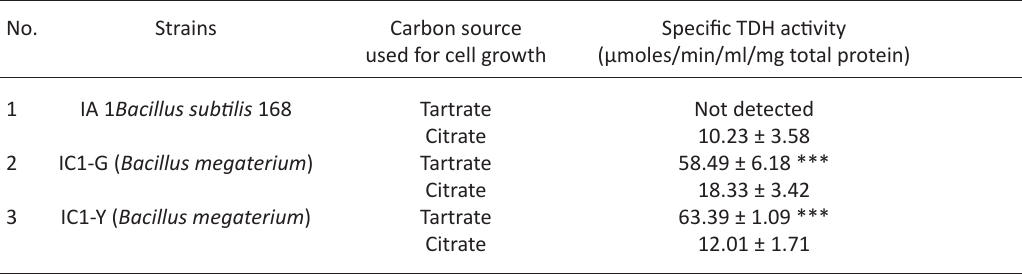
Table 2. Occurrence of inducible tartrate dehydrogenase activity in L-tartrate-utilizing Bacillus isolates